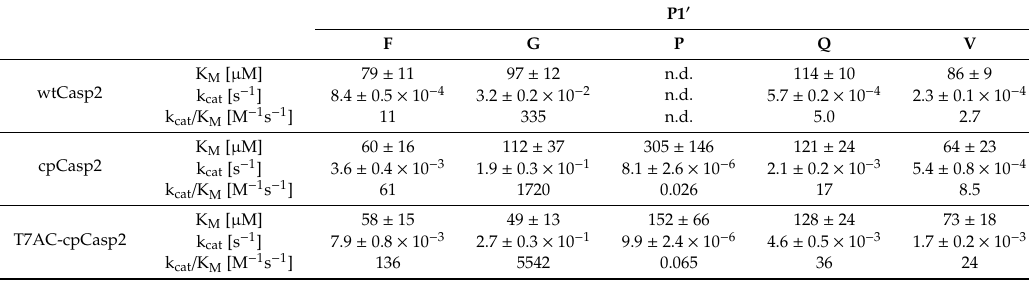
Table 2. Selected Michaelis–Menten parameters of peptide cleavage with Casp2 variants.